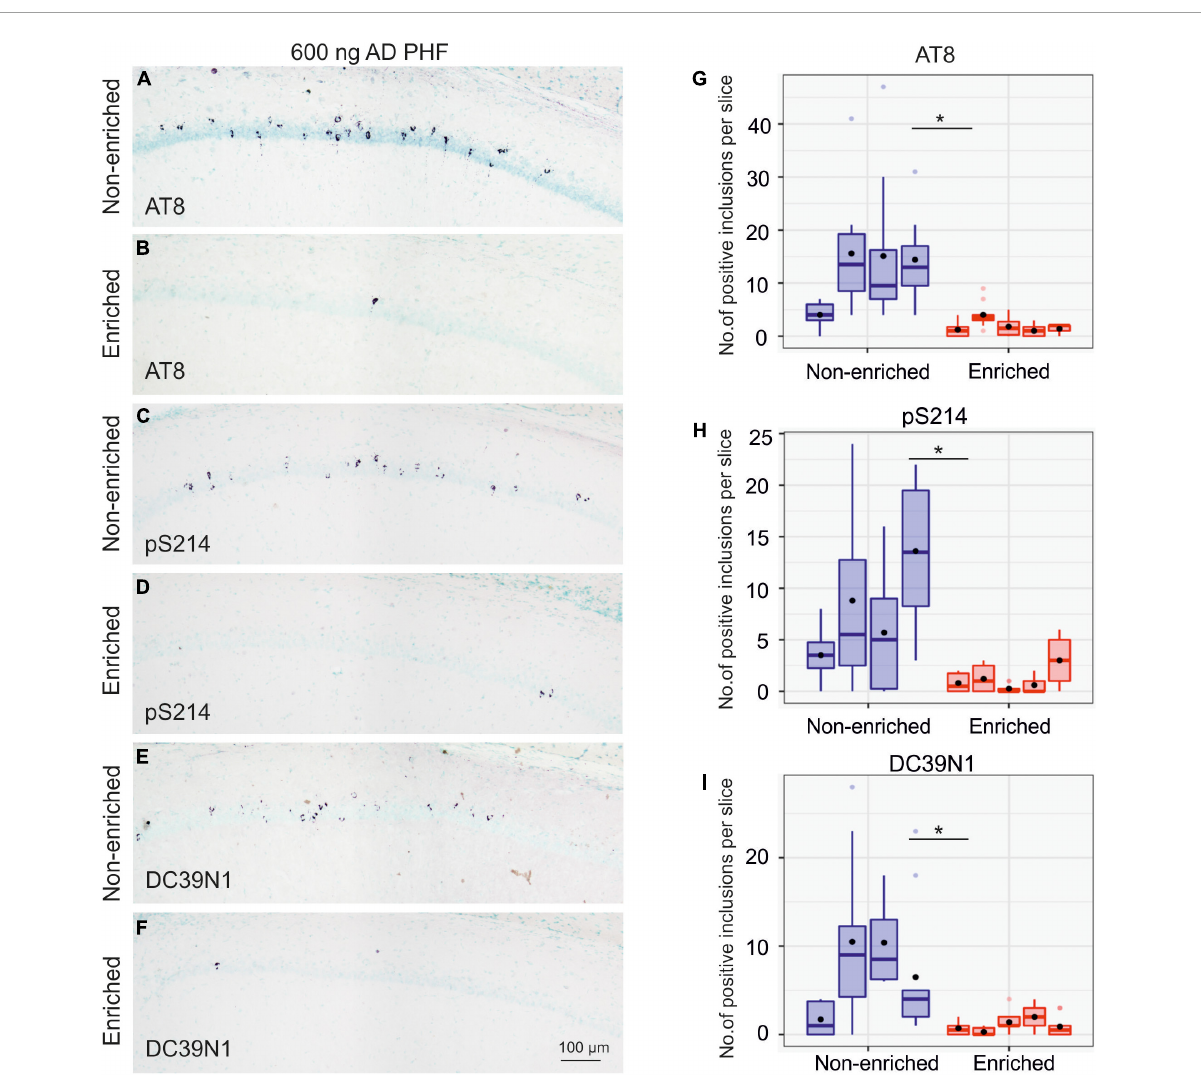
FIGURE4 Enriched environment leads to less propagation of tau pathology in the group injected with 600 ng AD PHF tau. (A–F) Representative sagittal sections of the hippocampus of SHR72 rats injected with 600 ng human AD PHF tau. For IHC staining phospho-tau dependent antibodies AT8 (A,B) , pS214 (C,D) and human tau specific antibody DC39N1 were used (E,F) . Scale bar: 100 µ m. (G–I) Quantitative analysis of tau pathology stained with phospho-tau dependent antibodies AT8 (G) , pS214 (H) , and human tau specific antibody DC39N1 (I) . A significant decrease in the amount of accumulated tau pathology is seen in the group exposed to enriched environment in comparison to the non-enriched, sedentary group (* p < 0.05; ** p < 0.01). Each column denotes one animal. Boxes indicate median and quartiles for tangle counts per brain slice; whiskers indicate quartiles ± 1.5 × IQR. Black dots indicate arithmetic